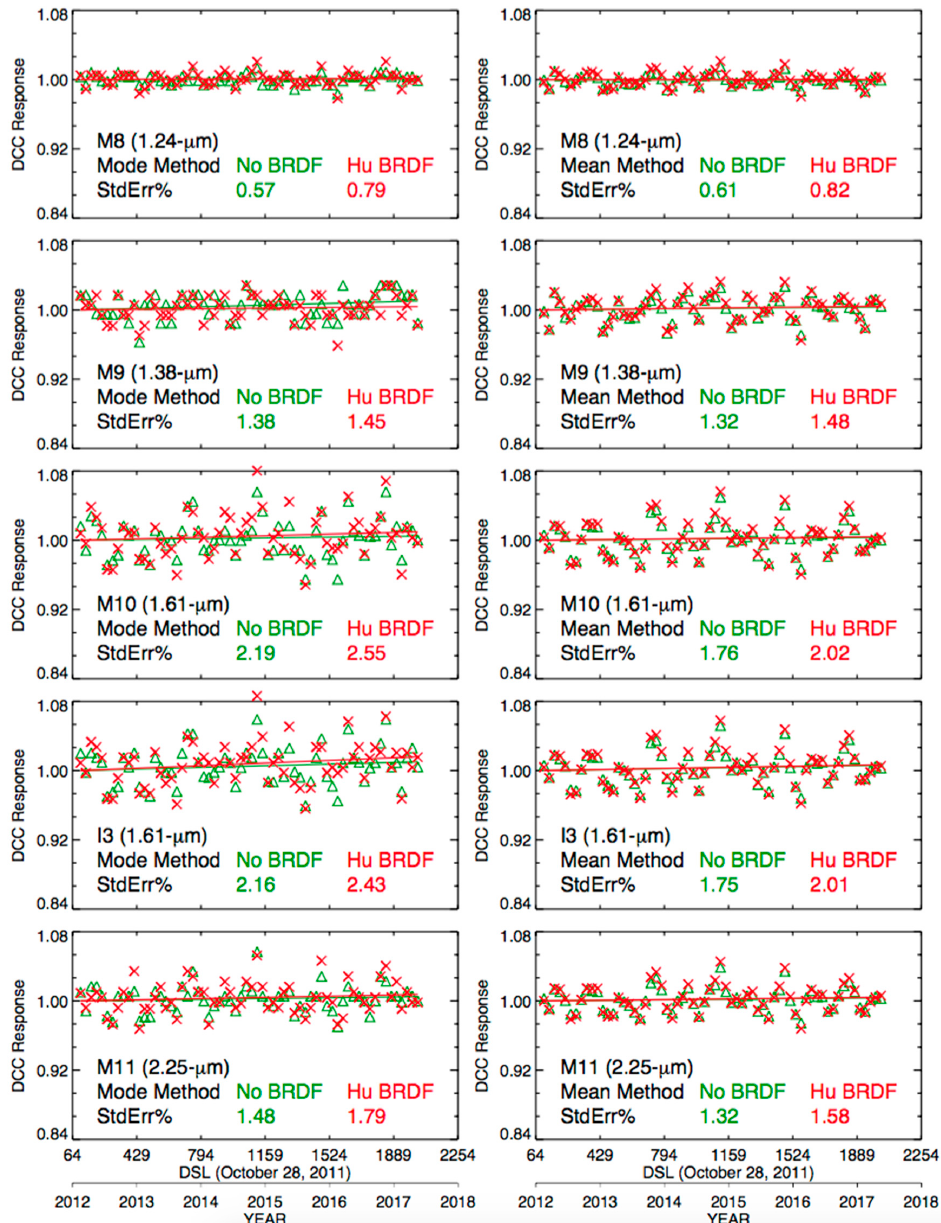
Figure 3. The normalized DCC Mode ( left ); and Mean ( right ) reflectance time series with ( red “×”) and without ( green “ Δ ”) Hu anisotropic corrections for VIIRS SWIR bands, with corresponding linear trend line and standard error in